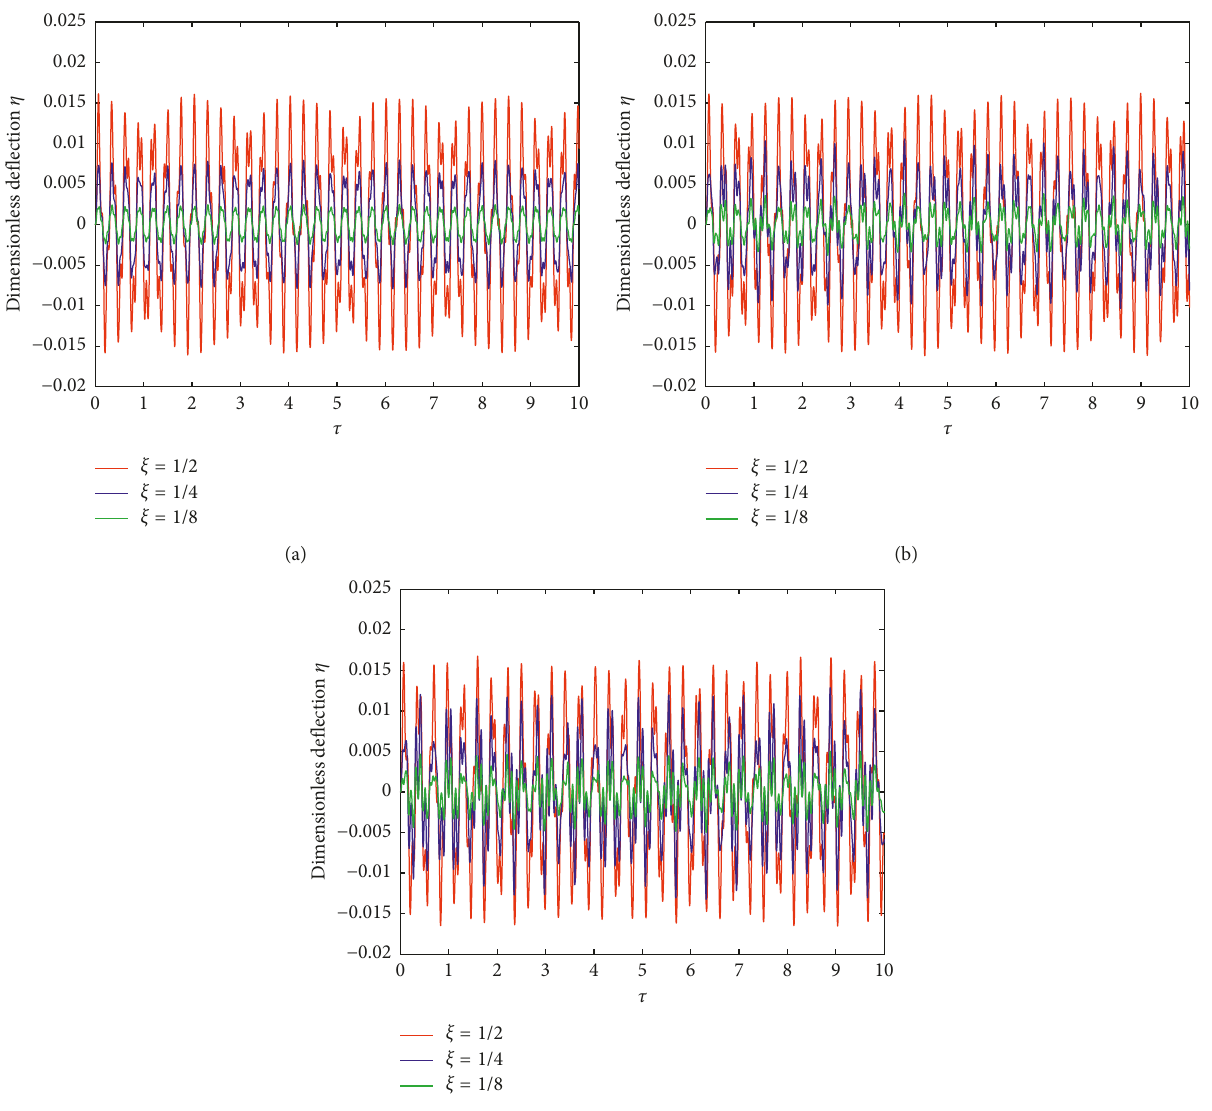
Figure 19: History curves of the deflection of the clamped-pinned pipe at different locations when having different fluid velocities: (a) u � 0; (b) u � 1; (c) u �